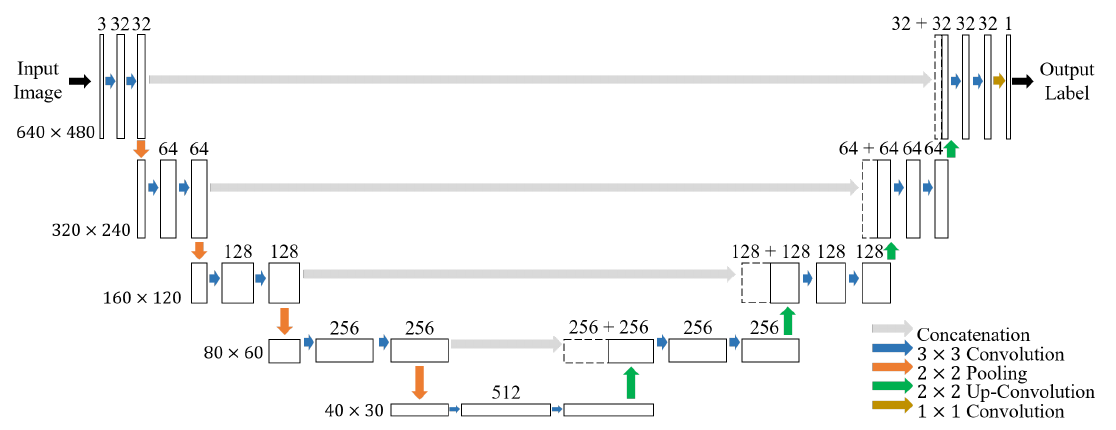
Figure 4. Proposed deep learning model for capillary